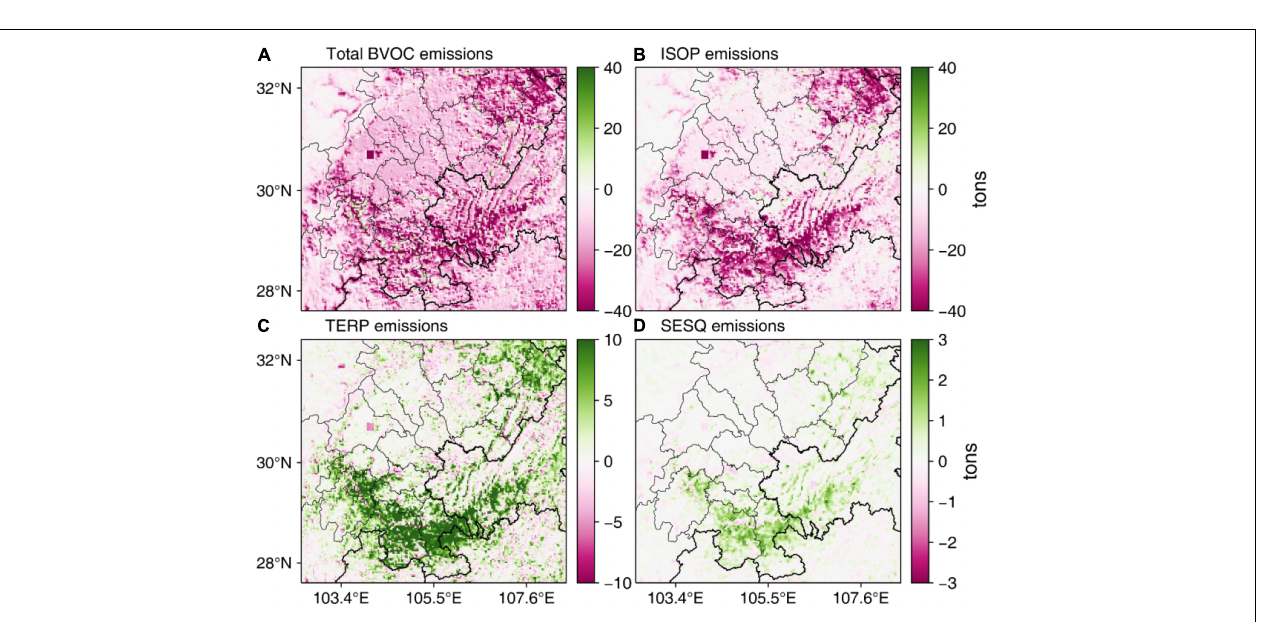
the highest O 3 levels in July (monthly average MDA8 O 3 reaching 140 µ g/m 3 ). High levels of O 3 are also found in southern SCB and metropolitan Chongqing where monthly average MDA8 O 3 is higher than 120 µ g/m 3 . For DM1h O 3 , the hotspots of O 3 are much more clearly distinguishable, particularly featured by a broader region under high O 3 exposure (DM1h O 3 higher than 200 µ g/m 3